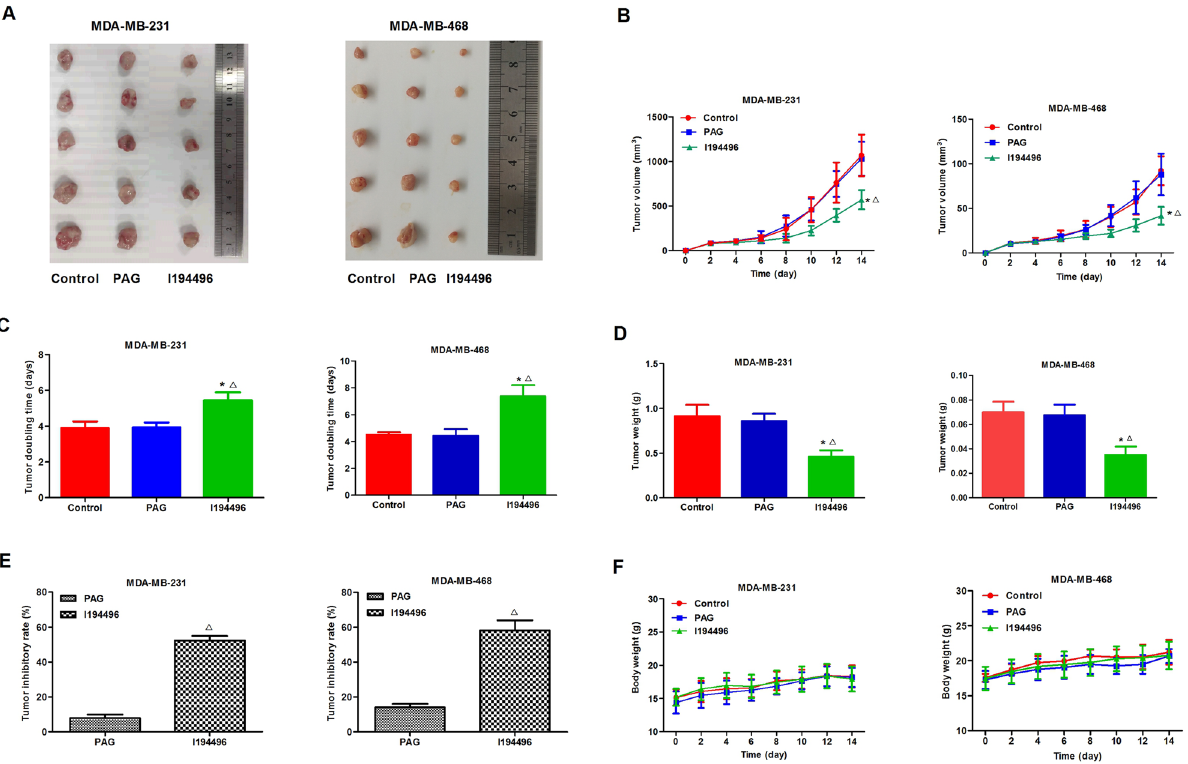
Figure 7. Effects of I194496 on the growth of MDA-MB-231 and MDA-MB-468 xenograft tumors in nude mice. ( A ) The tumors (xenografts) dissected from different groups of nude mice. ( B , C ) The tumor volume of each group was measured every other day after tumor growth and the TVDT was calculated by the formula shown in the methods. ( D , E ) The tumors dissected from different groups of nude mice were weighed and the inhibition rates of tumor growth were calculated by the formula shown in the methods. ( F ) The body weight change curve of each group during the experiment. All values are presented as mean ± SEM (n = 5); *P < 0.05 compared with the control group; △ P < 0.05 compared with PAG